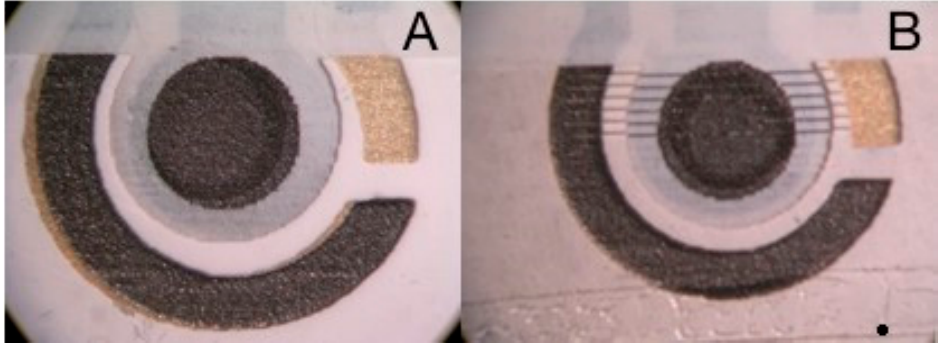
Figure 1. Optical micrographs of a freshly prepared, untreated Bi/PO 4 /PSS electrode before ( A ) and after ( B ) the laser ablation ICP-MS experiment.